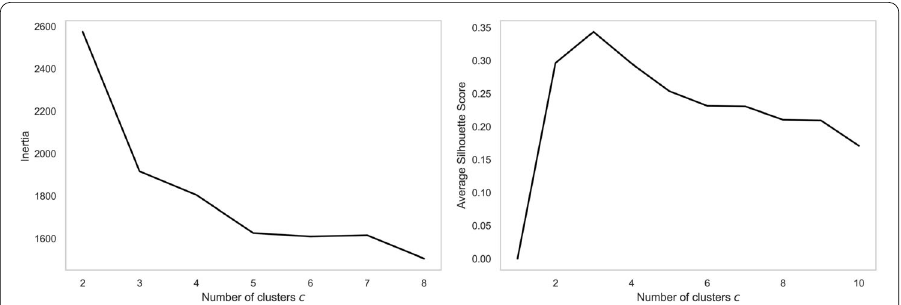
Figure 13 Methods to choose best c for pattern clustering, on left plot, elbow of the curve happens at c = 3 and 5, on right plot, the clustering achieves highest average silhouette score at c = 3. Combining two plots together, we choose c = 3 as the best cluster number for pattern